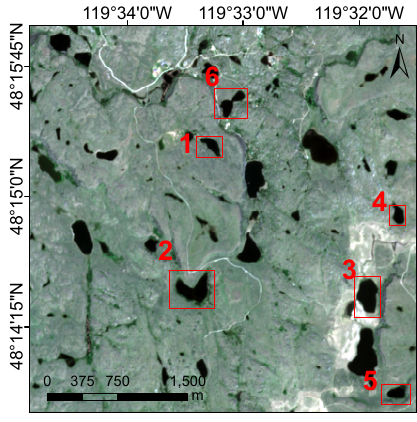
Figure 14. This analysis extracts hydrographs for wetlands surrounded by red frames. The numbers attached to rectangles denote the indexes of the